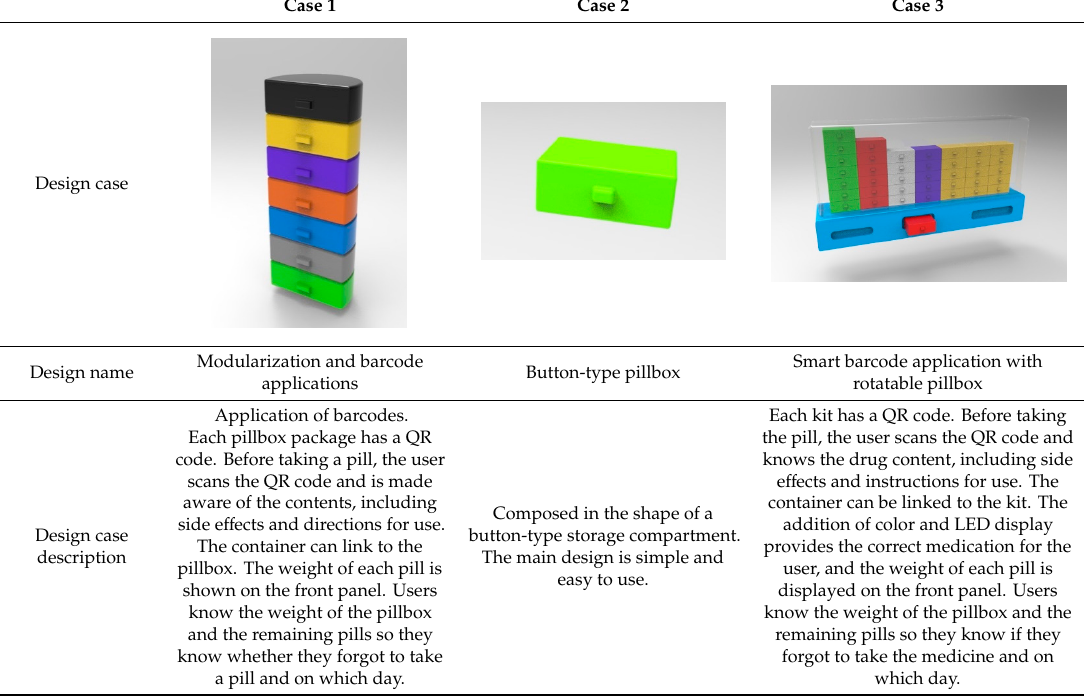
Figure 2. Weight set of the lower factors of the trolley selection indicator.